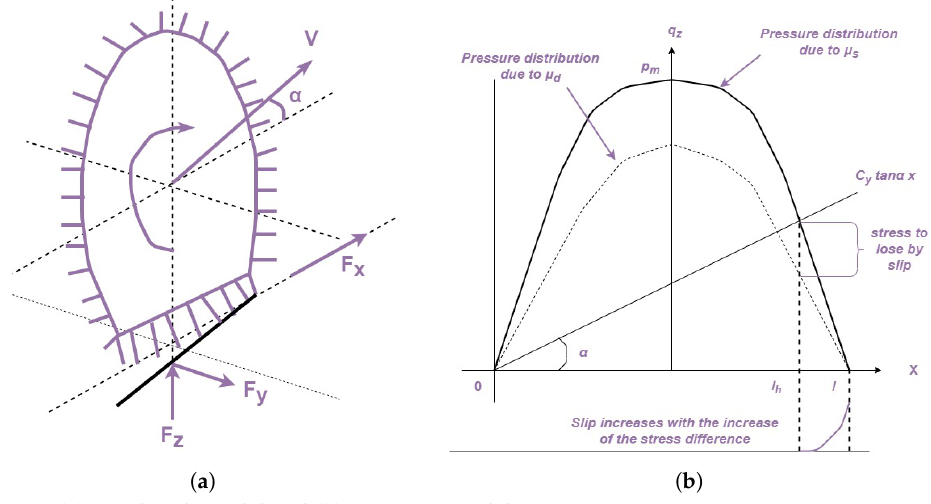
Figure 4. ( a ) Tyre brush model and ( b ) tyre wear model in